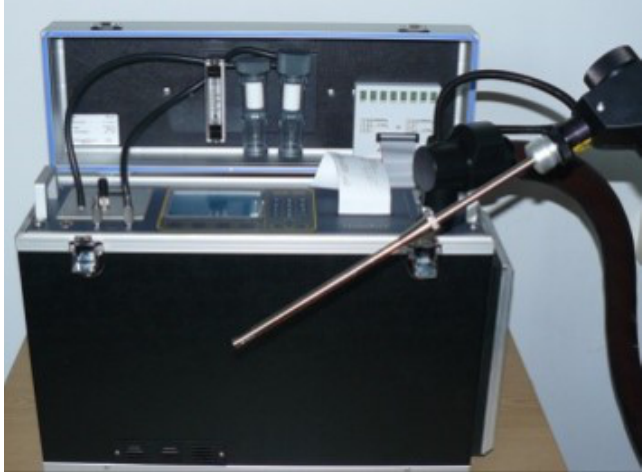
Figure 3. GA-60 emissions